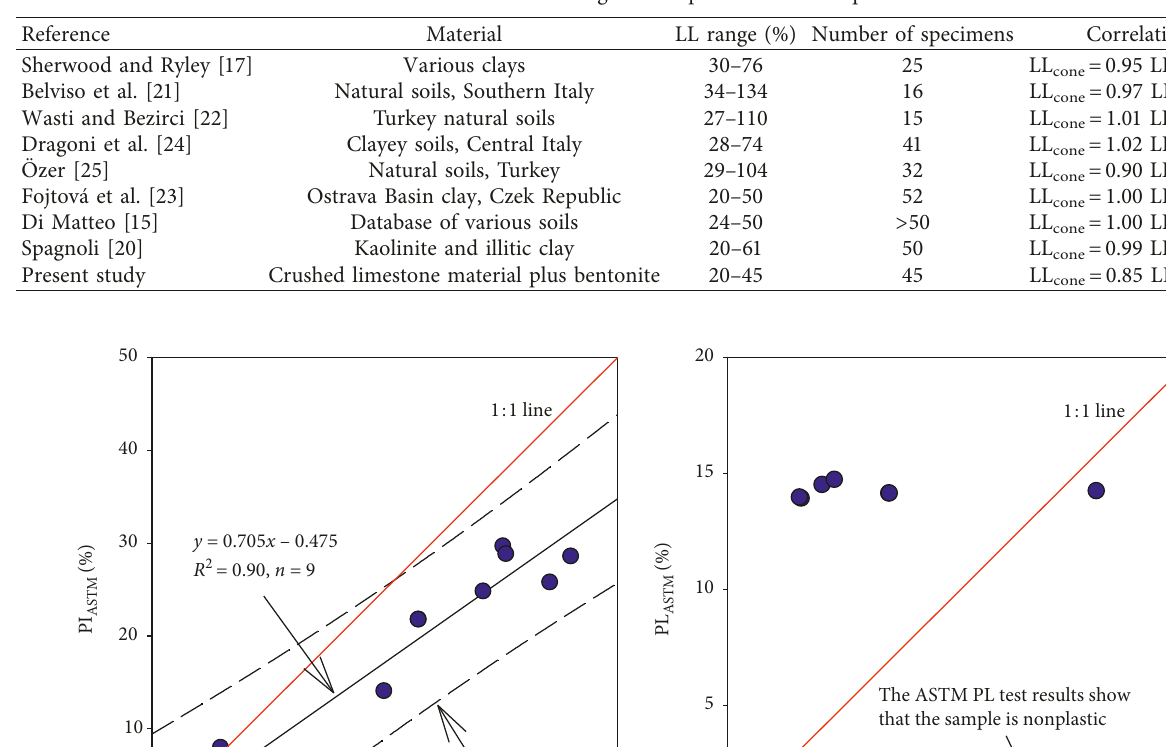
Table 4: Correlations between the Casagrande cup and fall cone liquid limit test results.